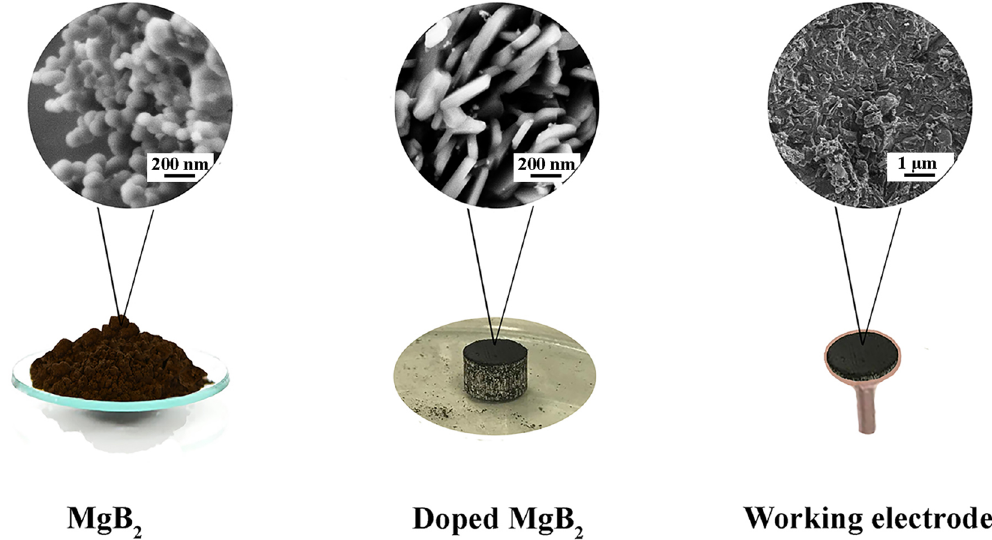
Figure 9. Illustration of final states of MgB 2 powder, doped MgB 2 pellets, and the working